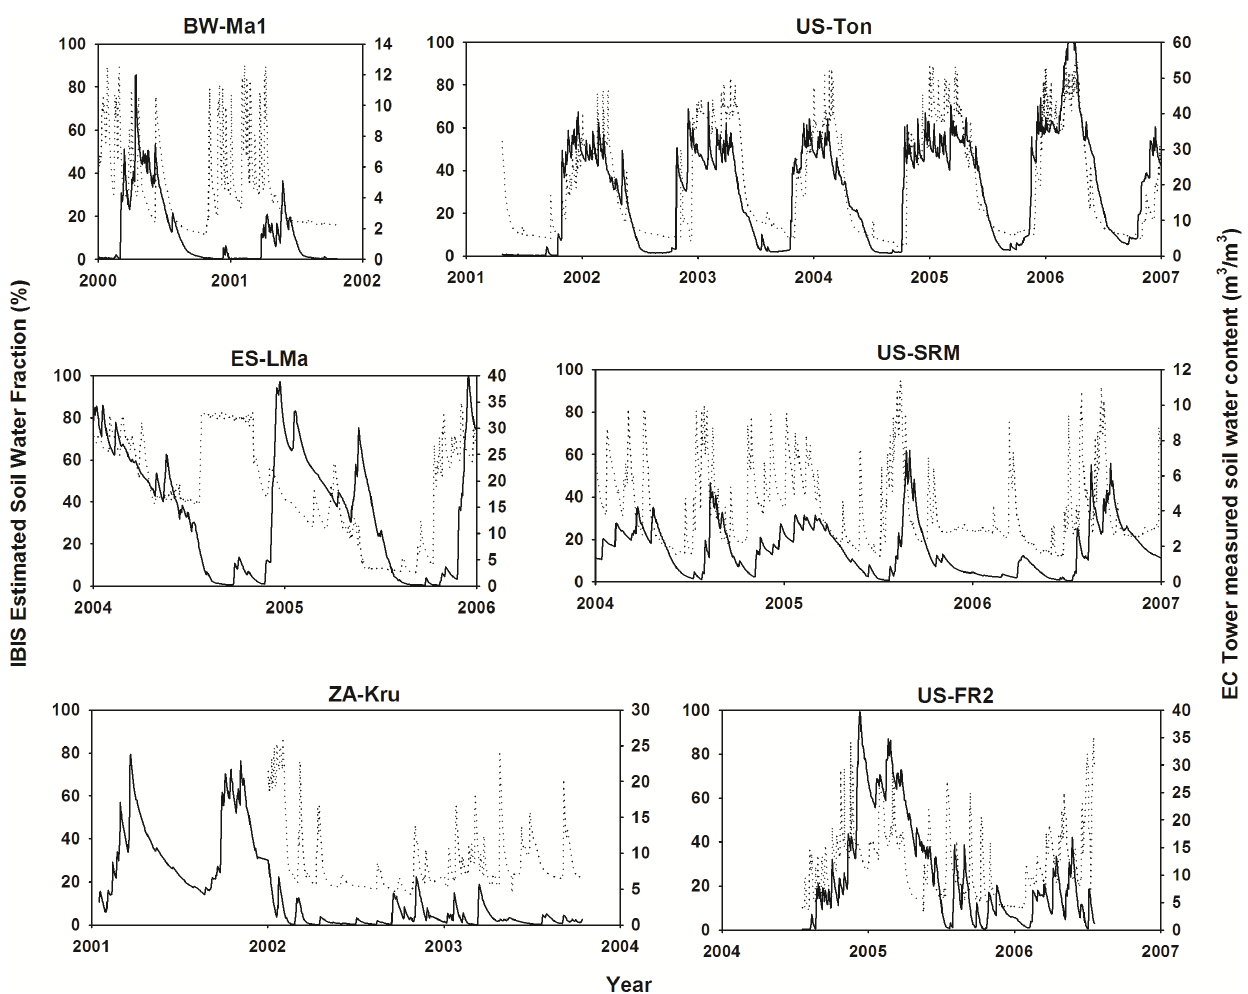
Figure 6. Comparison of estimated and observed soil water. Daily variation in the estimated soil water fraction of the IBIS model (i.e., fraction of soil pore space containing liquid water) and in the observed soil water content at EC sites. The solid lines represent simulation data, and the dotted lines represent the observed data.